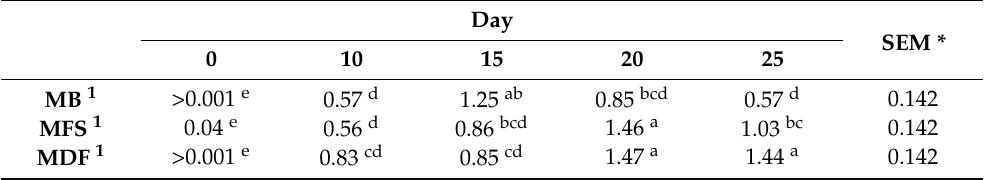
Table 2. Interactive effect of packaging method × day on aerobic (APC) spoilage organism growth.